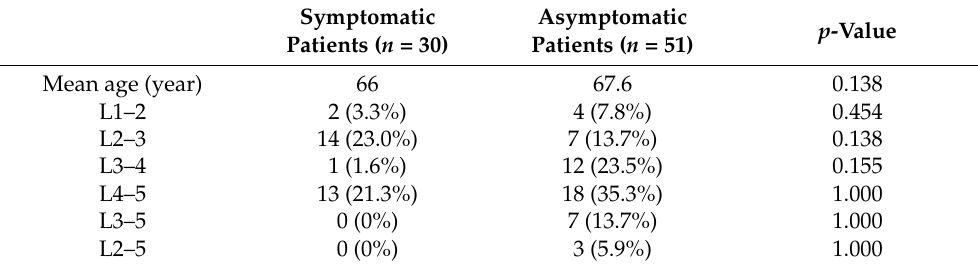
Table 2. Comparison of mean age and levels of surgery between symptomatic and asymptomatic